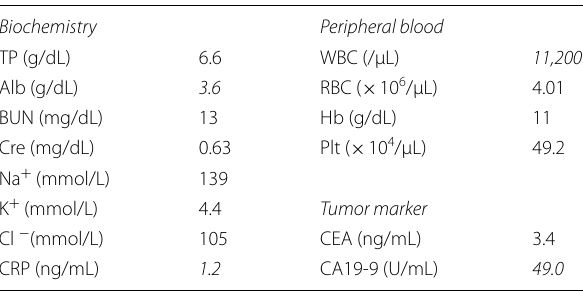
Table 1 Laboratory data at the patient’s first